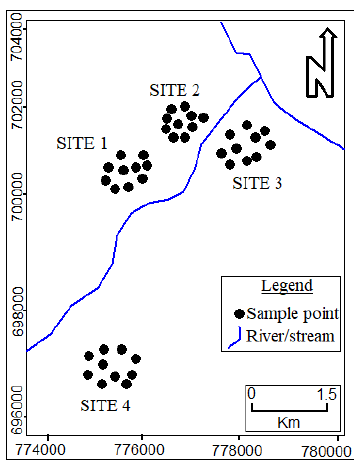
Soil sampling was done on four sites: site 1-3 being reclaimed sites, while site 4 (un-mined zone outside mine concession) was used as control. For each site 10 bulk samples weighing 500g were obtained from a pit at depth of 40cm from ground surface. From each of the sites, common food crops such as cocoyam and plantain parts were sampled from farms, while 10 water samples were also taken using 500 ml-sized clean plastic bottles along with the profile of a stream running through the area. The sampling area is presented in Fig.